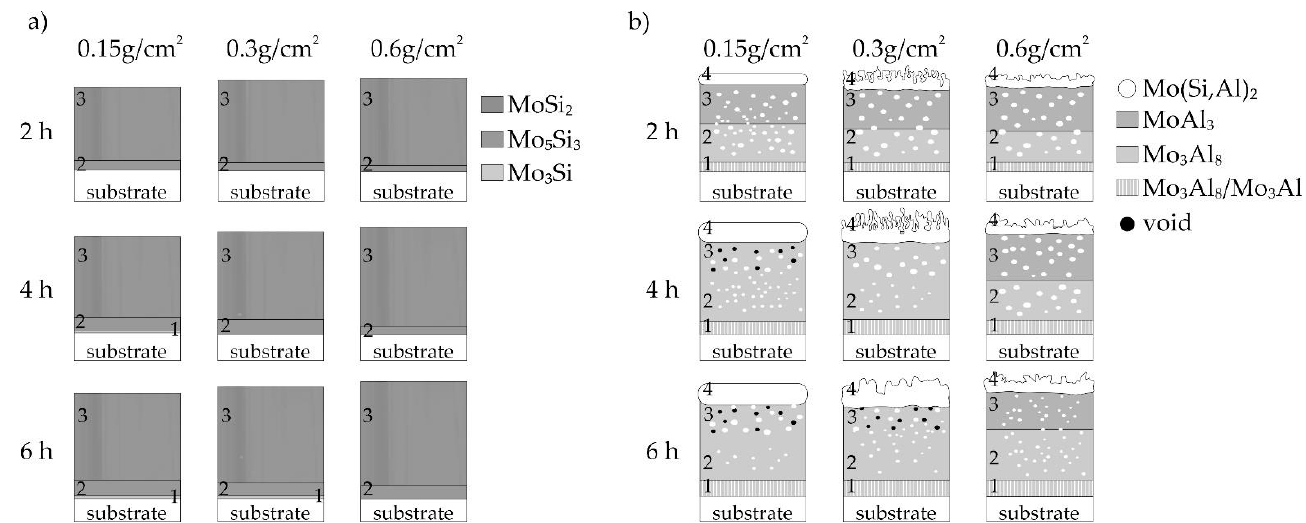
Figure 12. The scheme of the structure of ( a ) Si and ( b ) Si-Al coatings obtained on TZM alloy at 1000 °C for different slurry volume and different time.